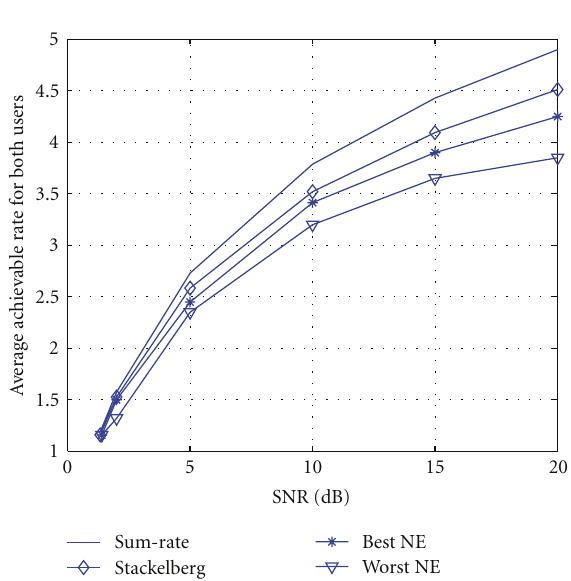
Figure 6: Average achievable rate for both users versus the signal- to-noise ratio for the centralized and Stackelberg approach. More- over, the best and worst Nash equilibria for the non-cooperative game are